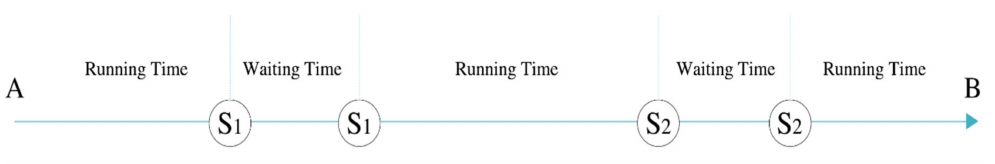
Figure 1. Running time and waiting time for a bus